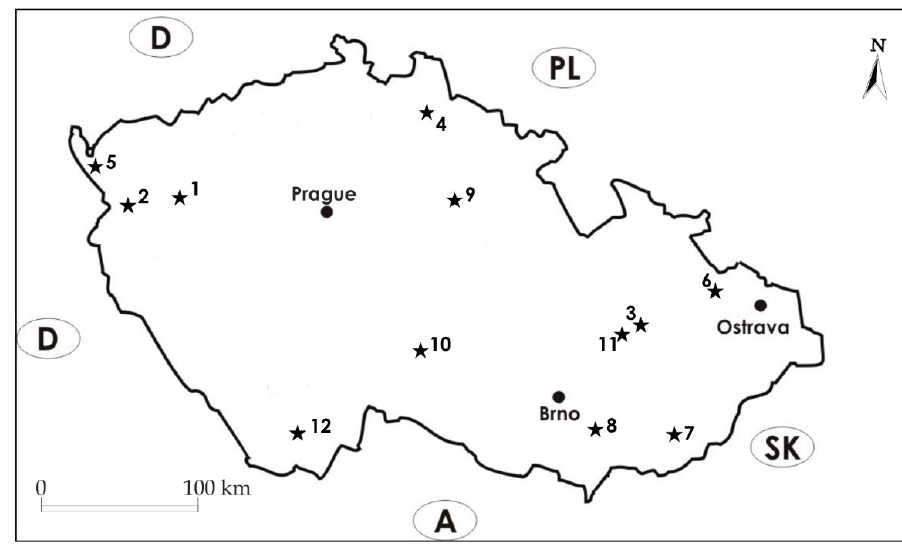
Figure 1. Location and numbering of contaminated sites tested in this study.